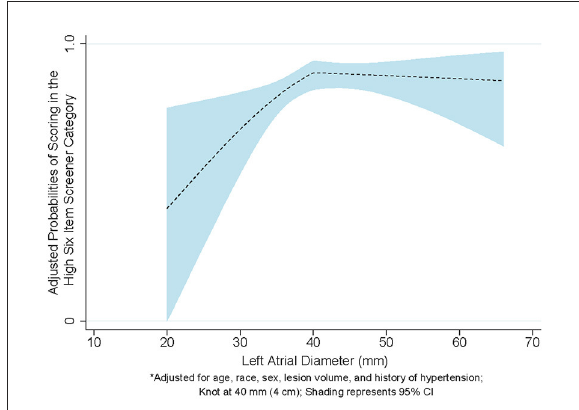
FIGURE2 Linear spline model demonstrating the association between left atrial diameter and six-item screener.